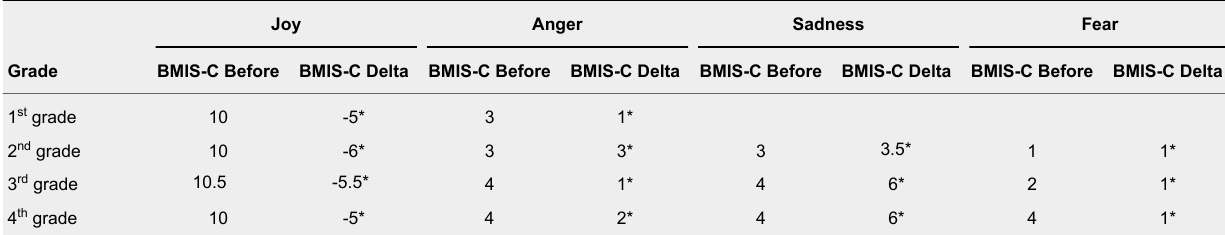
Evolution of the Emotional State Before and After Sadness Induction, According to the Student’s Grade and the Induced Emotion Joy Anger Grade